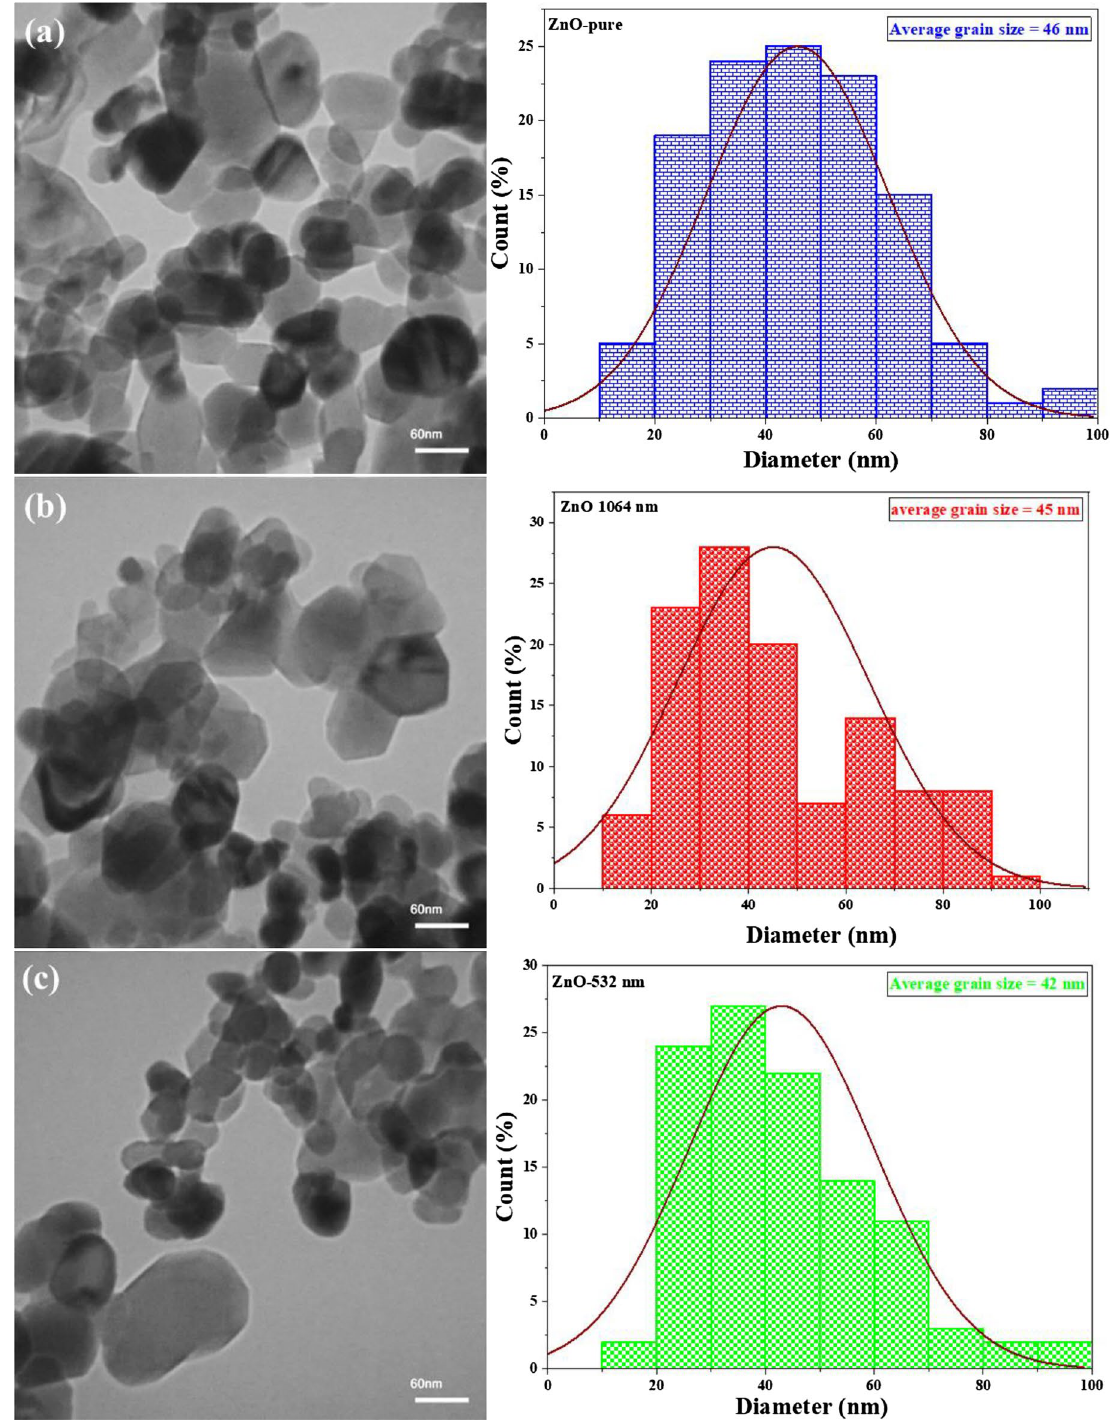
Figure 3. The TEM images and corresponding particle size histogram of the ZnO powders before ( a ) and after irradiation with laser having wavelength of 1064 nm ( b ), and 532 nm ( c